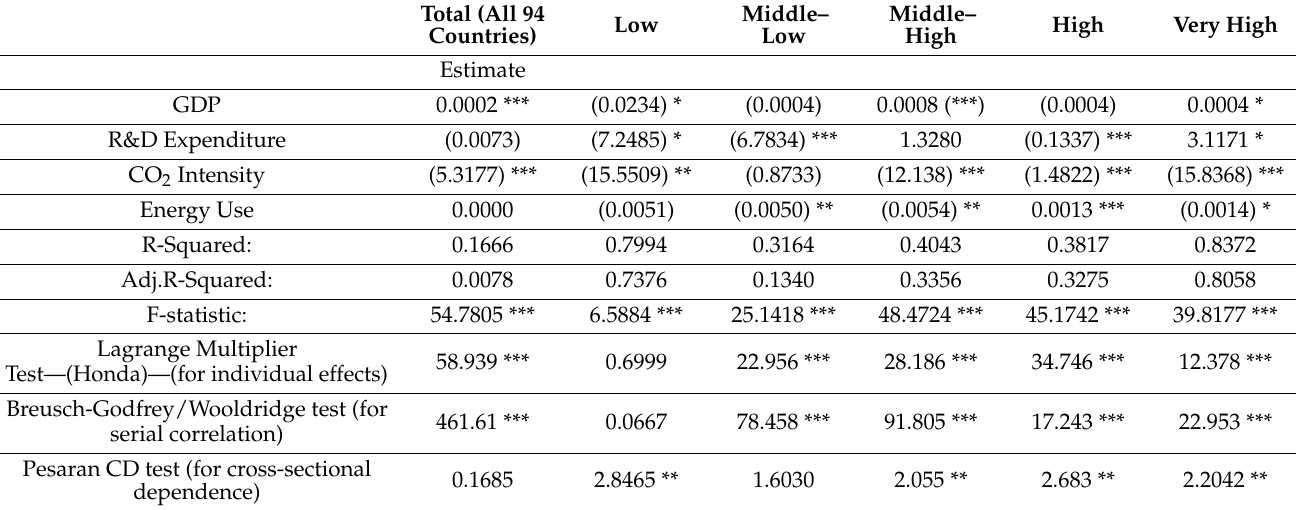
Table 4. Two-way country fixed effects (CFEM) with standard errors panel model results. Total (All 94